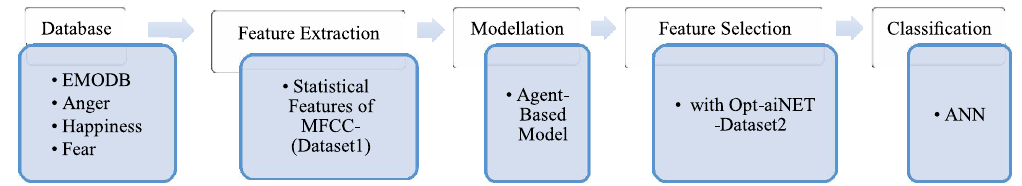
FIG. 3. THE STEPS OF PROCESS FOR DATASET1 AND DATASET2